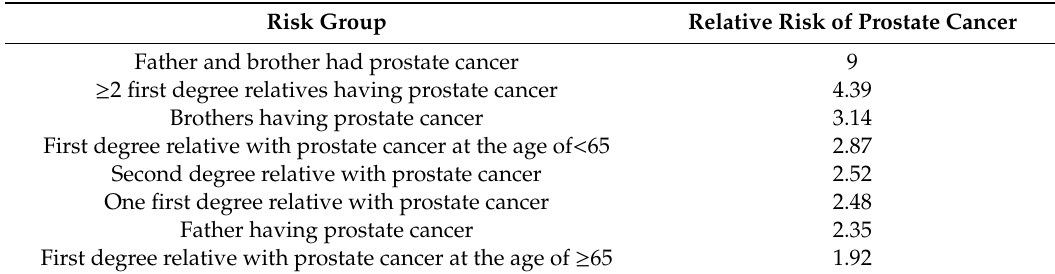
Table 1. Relative risk of prostate cancer in patients with a positive family